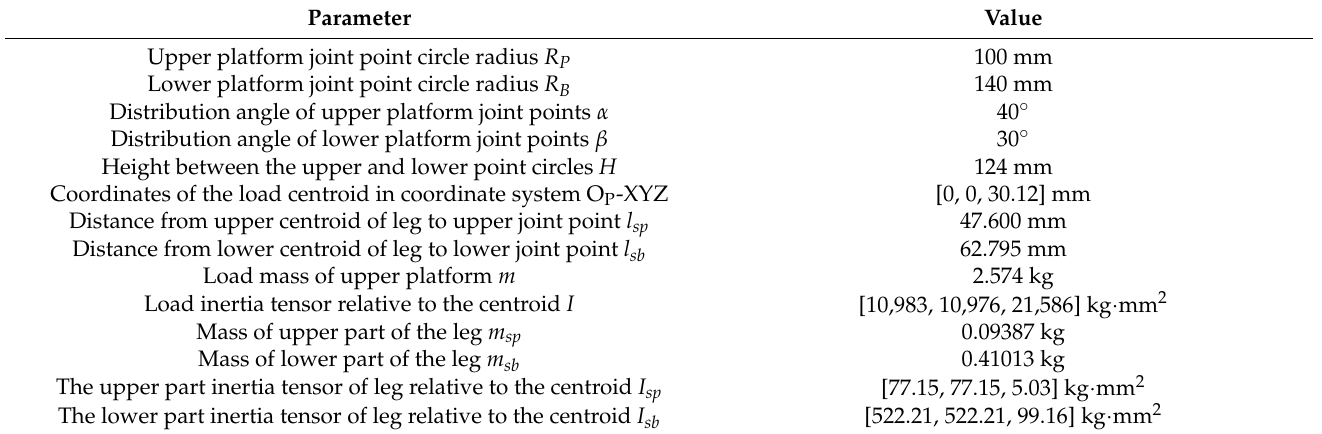
Table A1. Main parameters of Stewart platform.